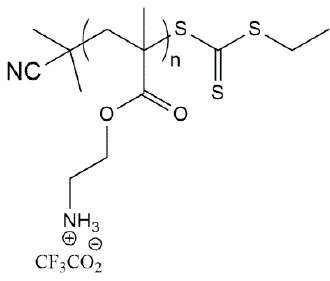
Figure 6. Chemical structure of ammonium ethyl methacrylate homopolymer (AEMPs)